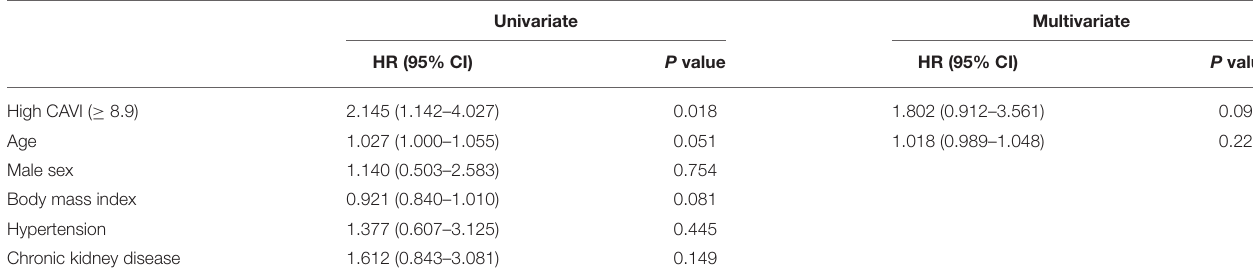
TABLE 5 | Cox proportional hazard model for all-cause mortality.